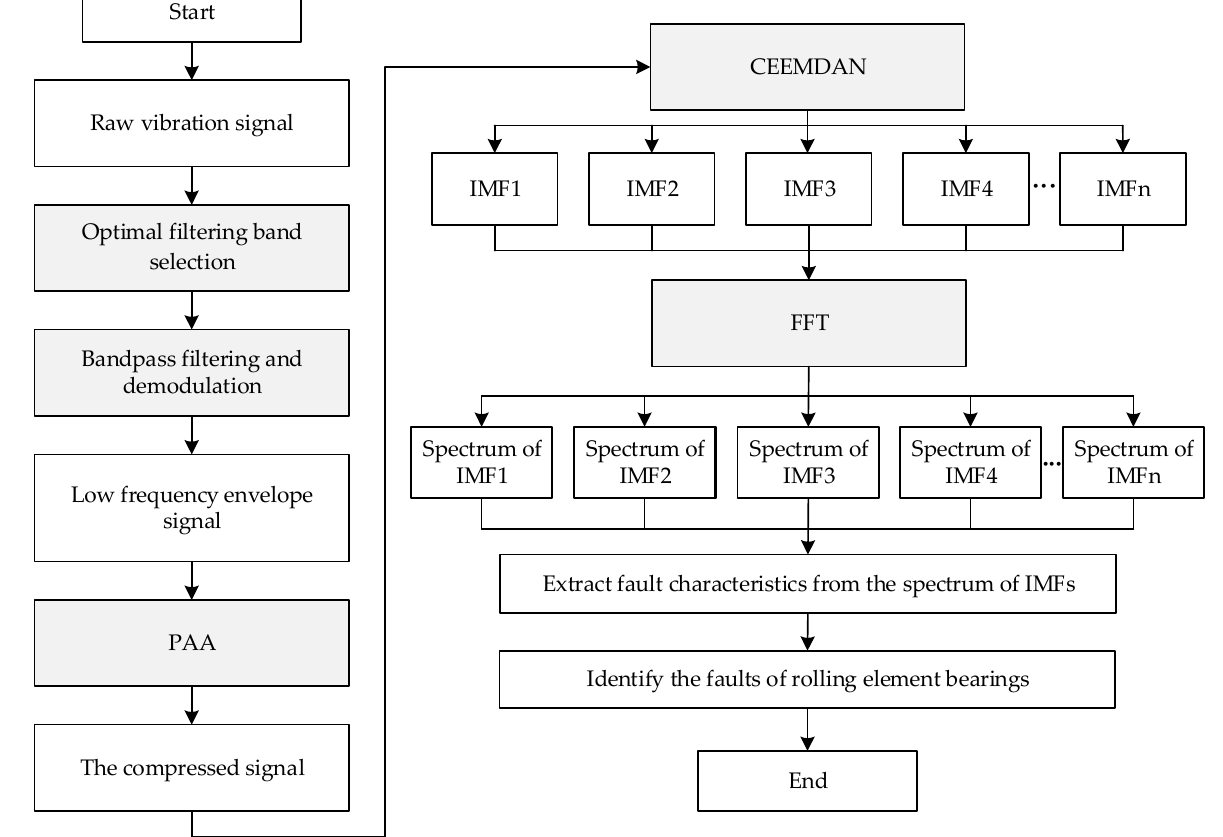
Figure 4. Flow chart of the proposed method.